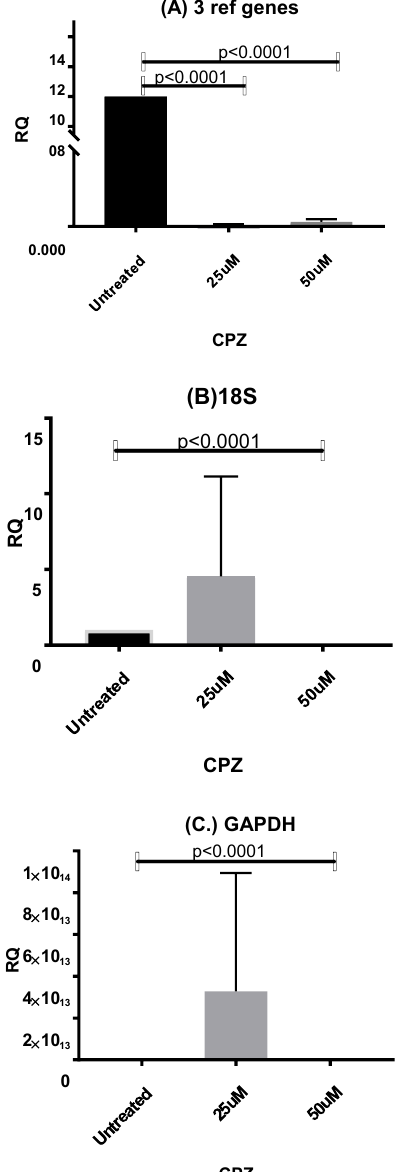
Figure 5. Fold change mRNA expression of senescence marker CDKN2A. The fold change in mRNA expression (±SD) of marginally expressed gene Cdkn in HepaRG cells stimulated with different doses of CPZ or APAP when mRNA expression was normalized using: ( A ) the geometric mean of the validated reference genes (n = 5), ( B ) 18S (n = 6), and ( C ) GAPDH (n = 5). The fold change of mRNA expression is relative to HepaRG untreated cells. CDKNA was not detectable in APAP-treated samples.